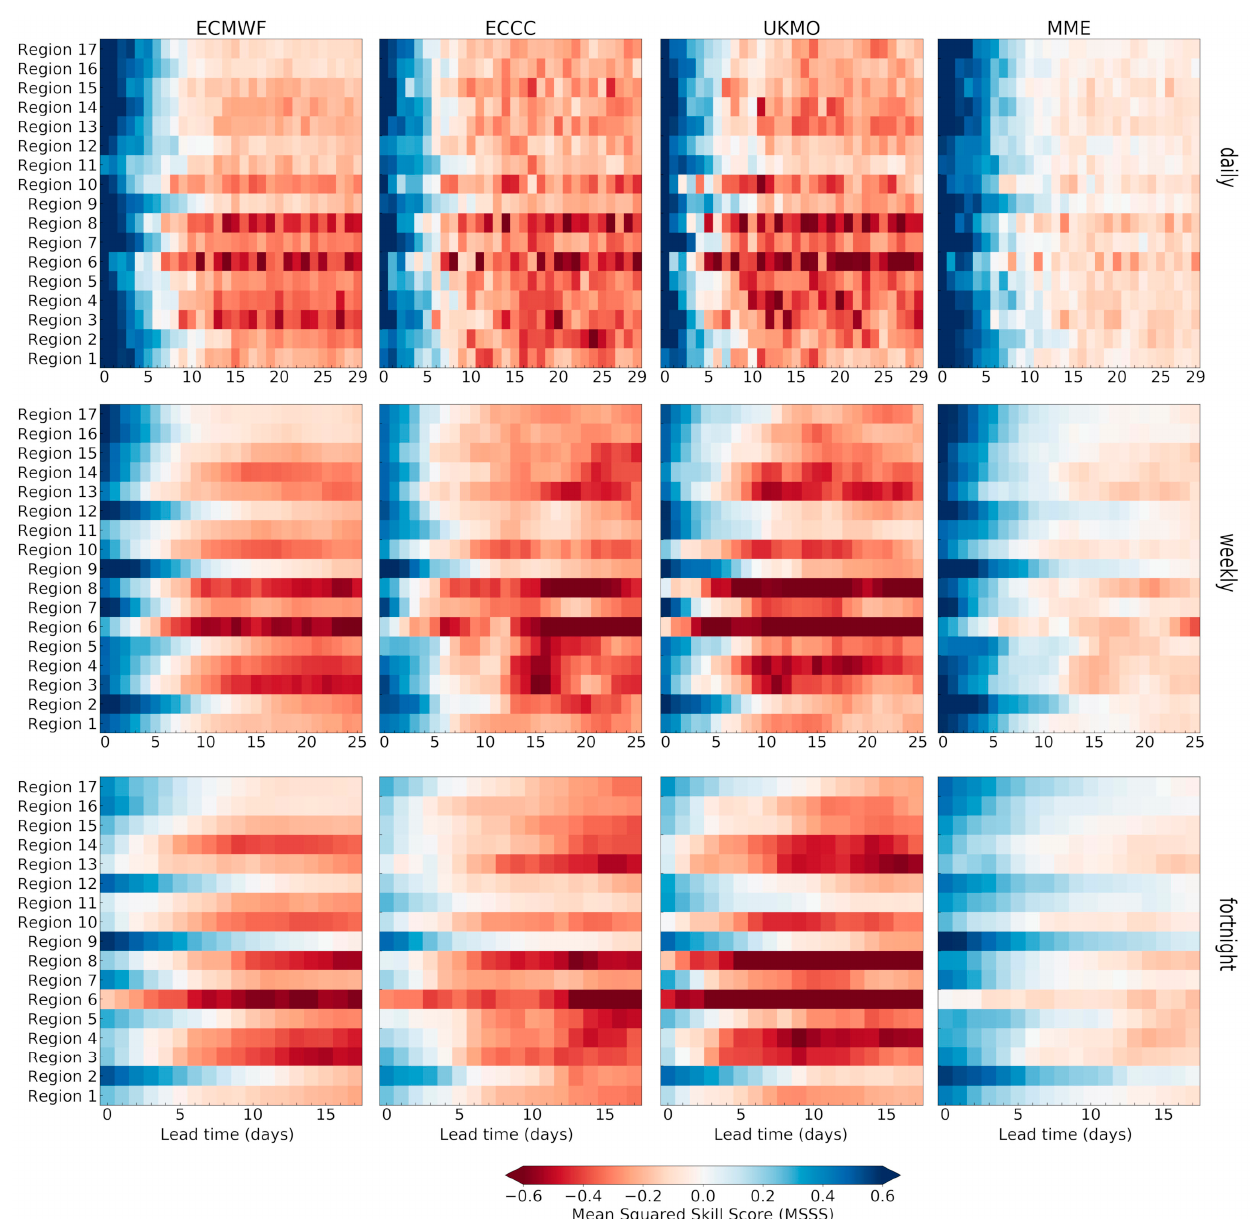
Figure 6. Mean squared skill score of sub-seasonal precipitation forecasts at different temporal scales (daily, weekly, and fortnight) of the ECMWF model, the ECCC model, the UKMO model, and the MME model for each region during the boreal summer monsoon.